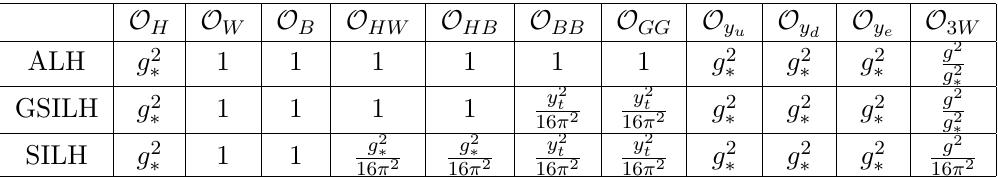
Table 7 . Estimation of the magnitudes of c i ’s for the operators in table 6 for the three scenarios of ALH, GSILH, and SILH. Note the di(cid:11)erence between this and table 2 of ref. [96] is due to the di(cid:11)erent normalization of